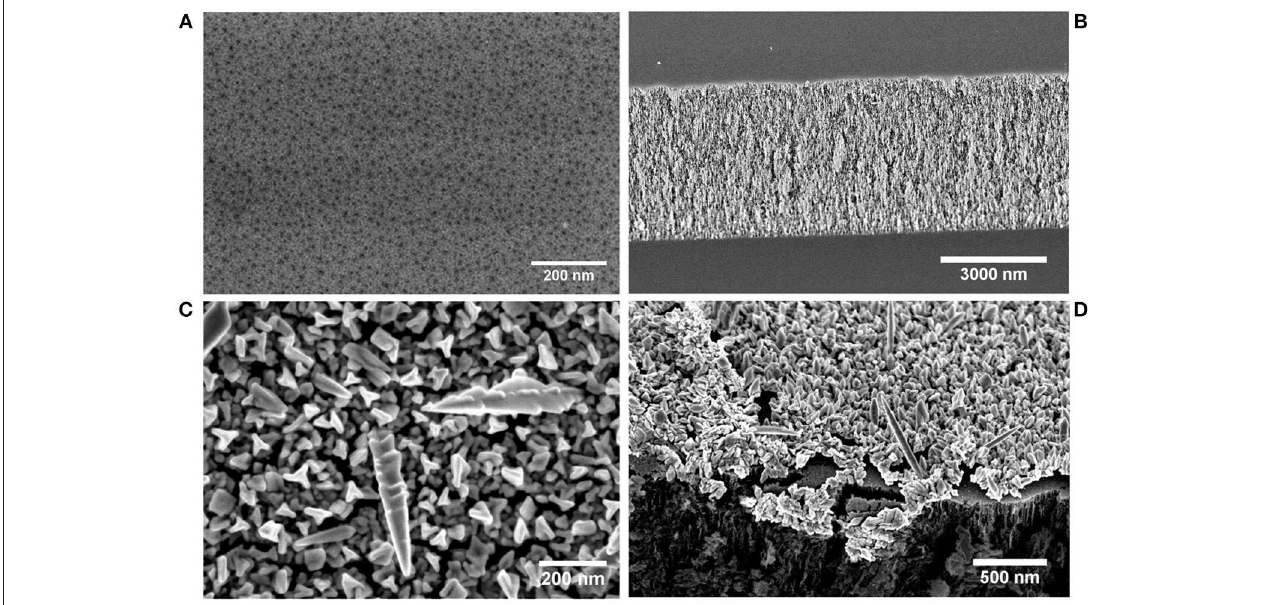
FIGURE 1 | Secondary electron micrographs of the fabricated sensors. (A) Top view of a freshly etched PSi layer. (B) Cross-section of a freshly etched PSi layer. (C) Top view of gold nanostructures grown on a freshly etched PSi layer. (D) Secondary electron micrograph of gold nanostructures on a PSi layer taken with a 45 ◦ tilt